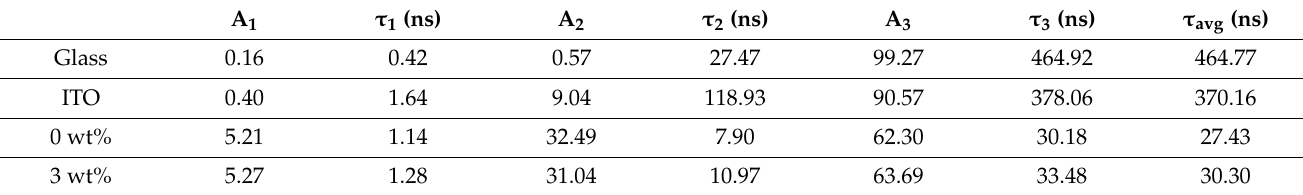
Table 2. Fitting parameters of time-resolved PL spectra of perovskite films on glass, ITO,